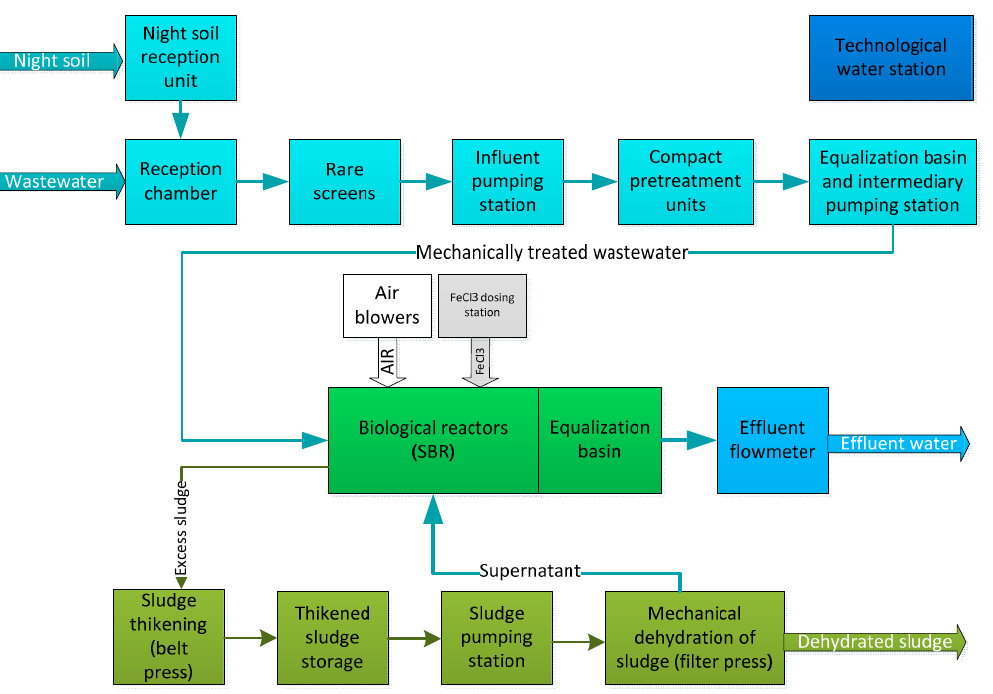
Figure 2. Process flow diagram for WWTP.